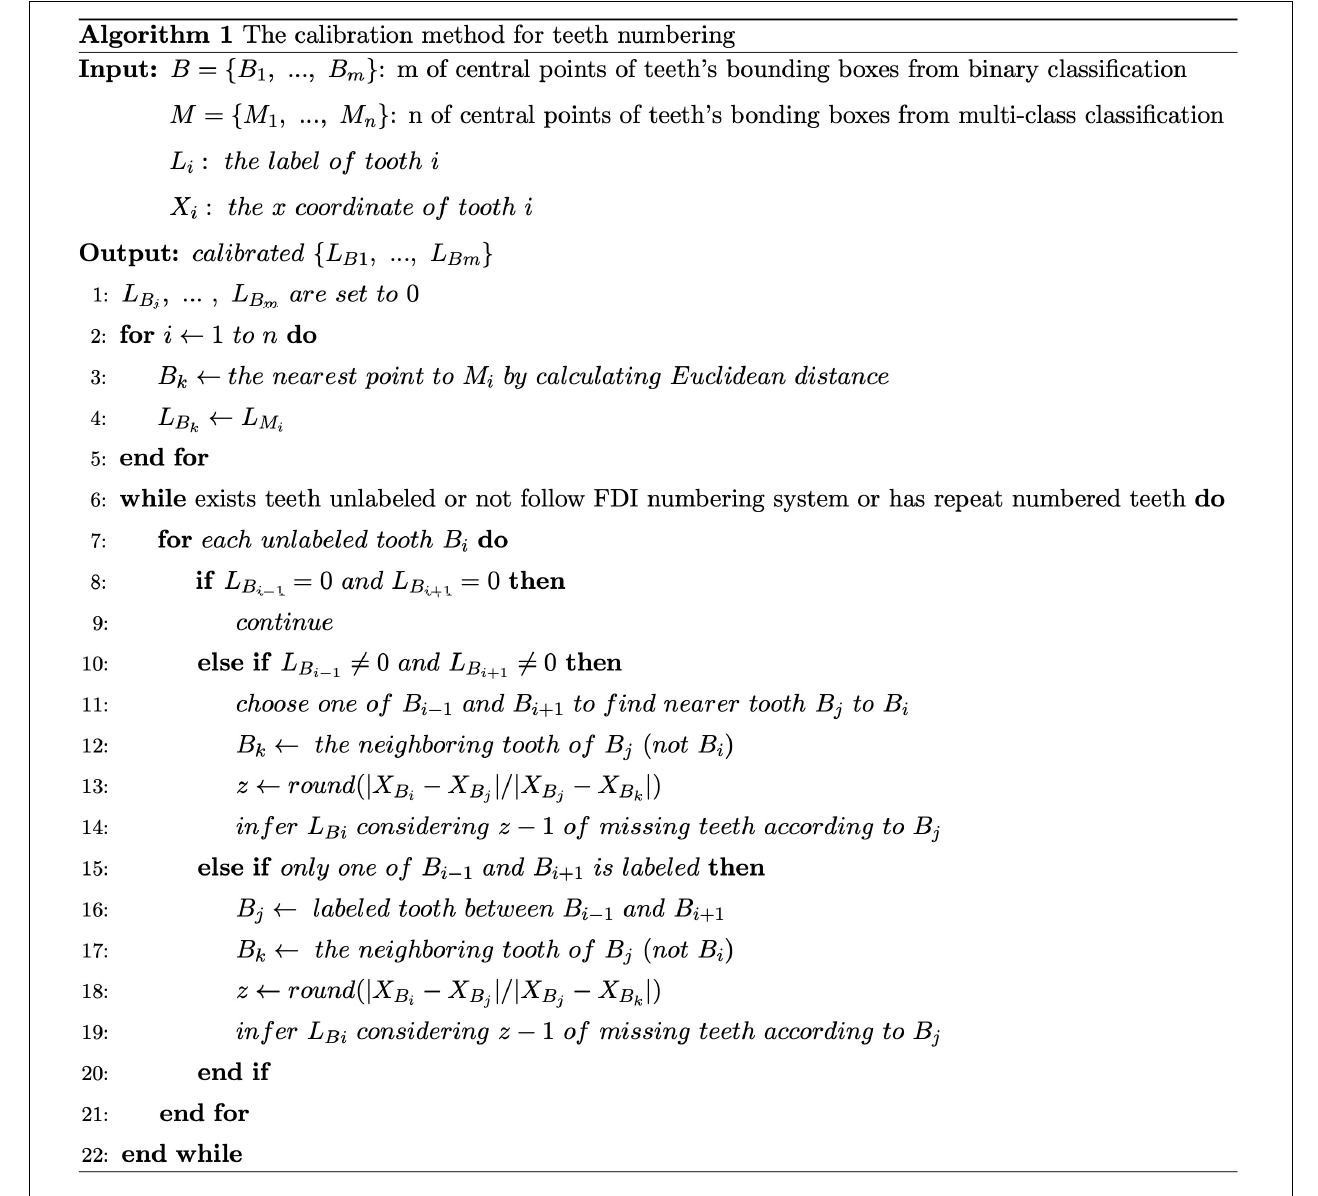
FIGURE 4 | The calibration algorithm for teeth